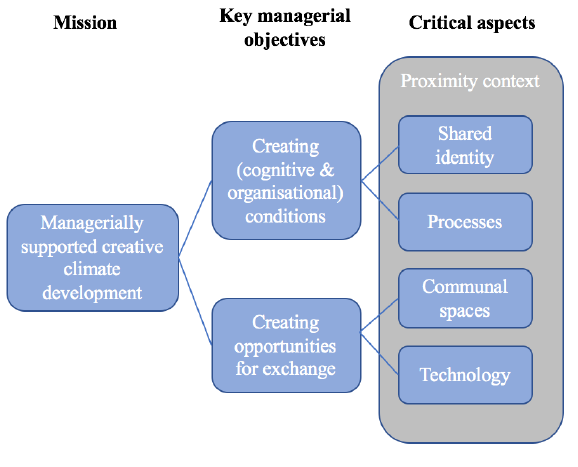
Fig. 1. Critical aspects to support creative climate development in a science